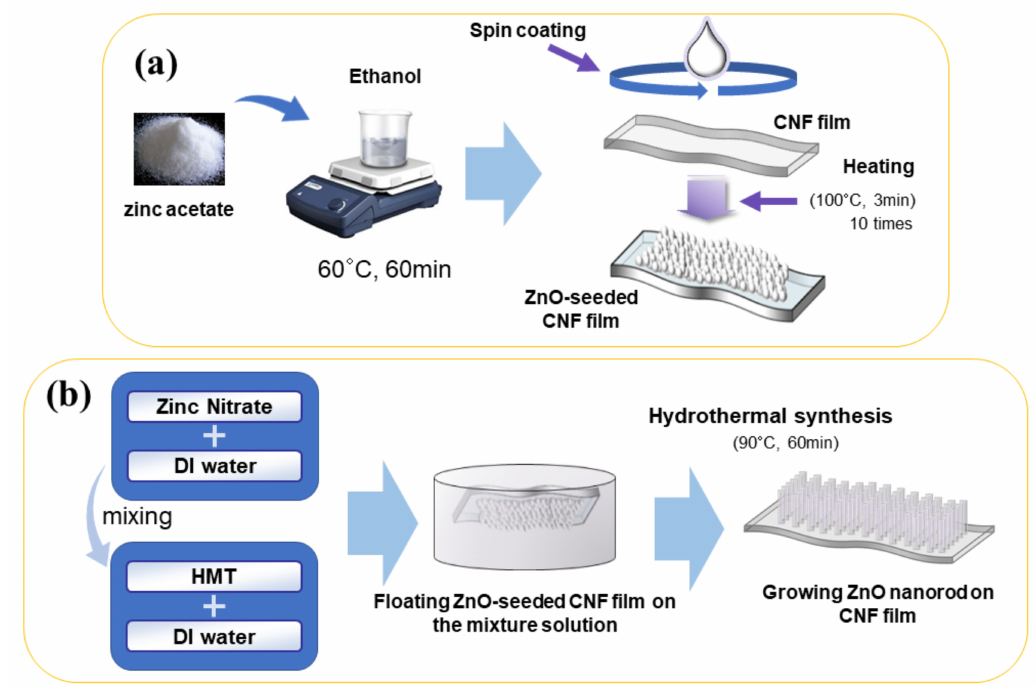
Figure 2. Schematic of ZnO-CNF nanocomposite fabrication process: ( a ) seeding process and ( b ) nanorod growing